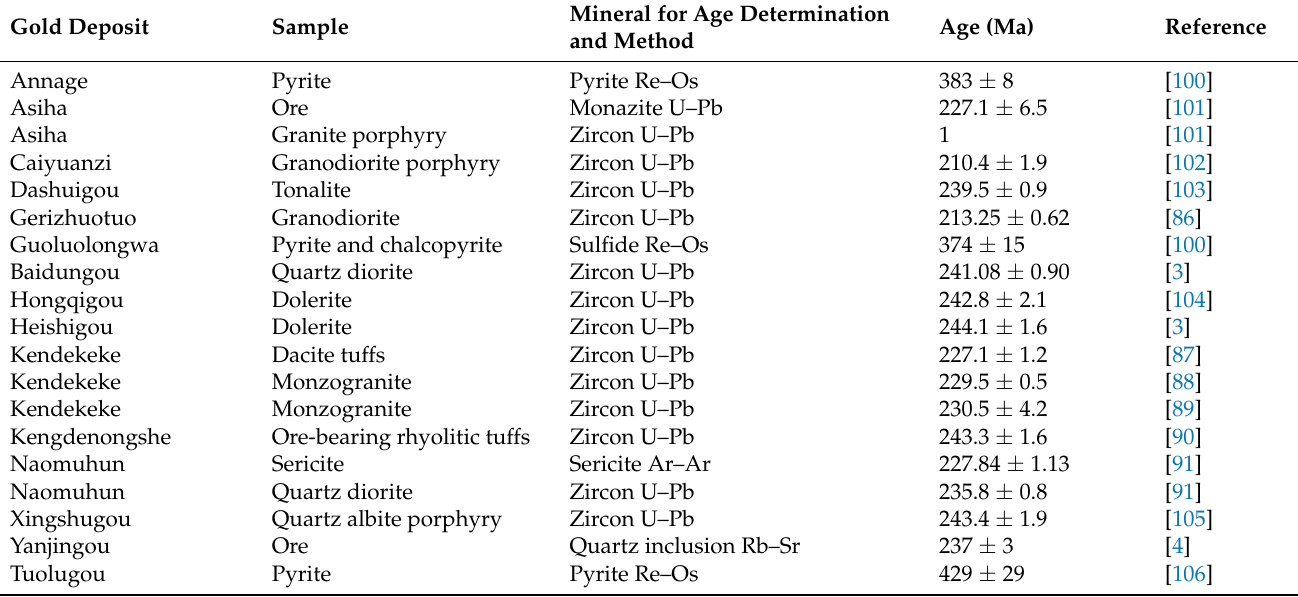
Table 4. Ages of the EKOB gold